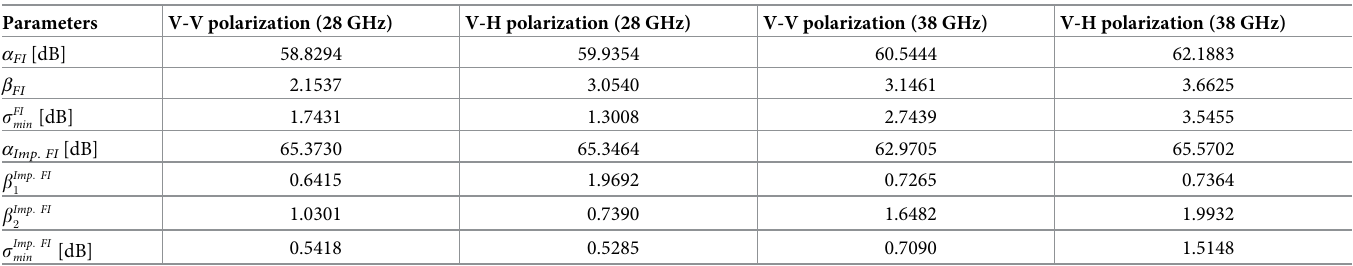
Table 4. Parameters for the standard FI and improved FI models for the LOS